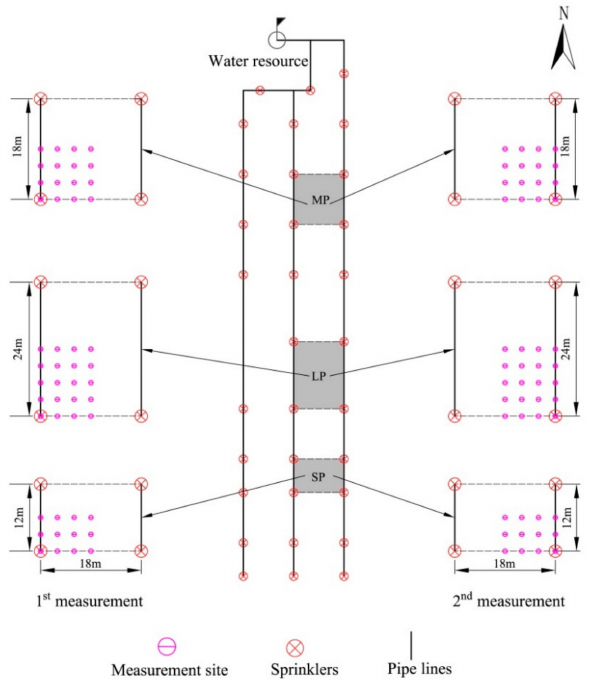
Figure 1. Measurement layout for water depth above and under the canopy, canopy interception, stemflow and throughfall water in the experiment. SP, MP and LP indicate the plots used for measurement in the three